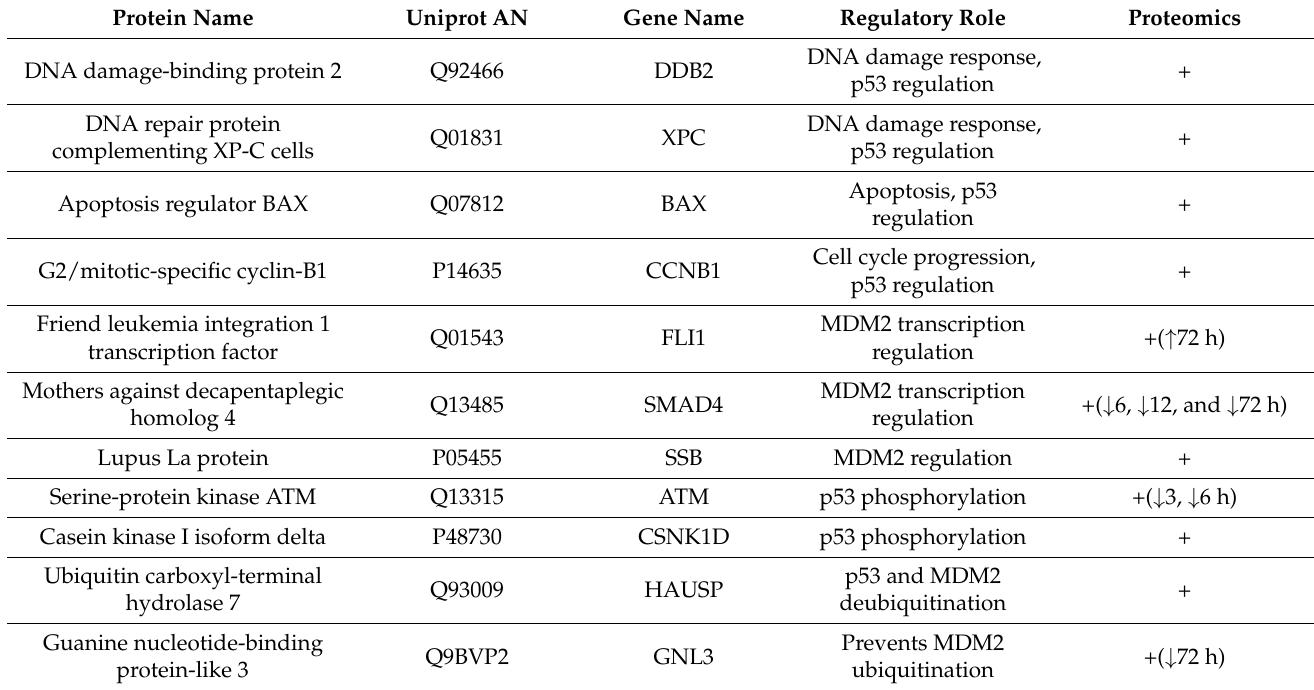
Table 1. Proteins involved in the regulation of p53 and MDM2 protein.+—detected in proteomic experiment, ↑ —increased expression, ↓ —decreased